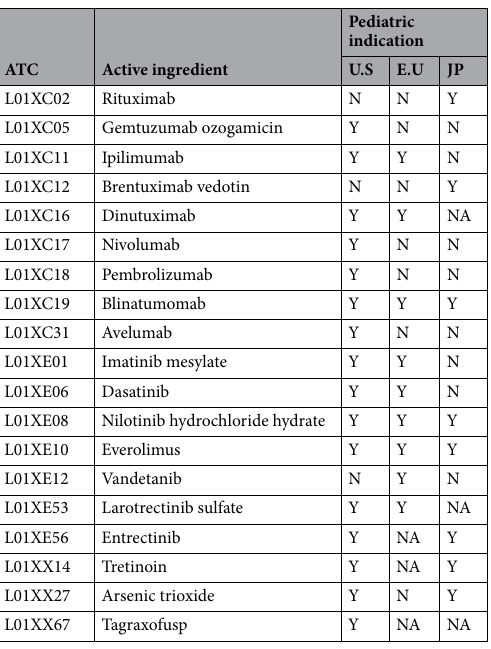
Table 1. List of molecular targeted antineoplastic drugs with pediatric indications. ATC The anatomical therapeutic chemical codes; U.S. United States; E.U. European Union; JP Japan; Y Yes; N No; NA Not approved for either adults or children (as of February